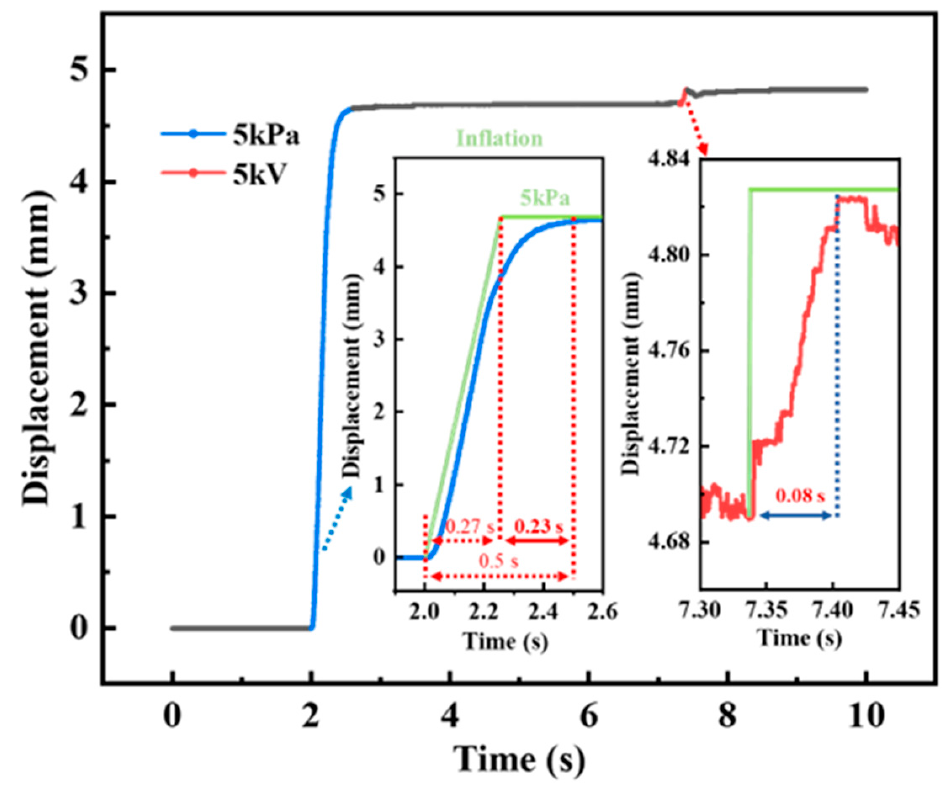
Figure 10. Response time of the SEHPA, in which 5 kPa was applied at 2 s and 5 kV was applied at about 7.34 s.